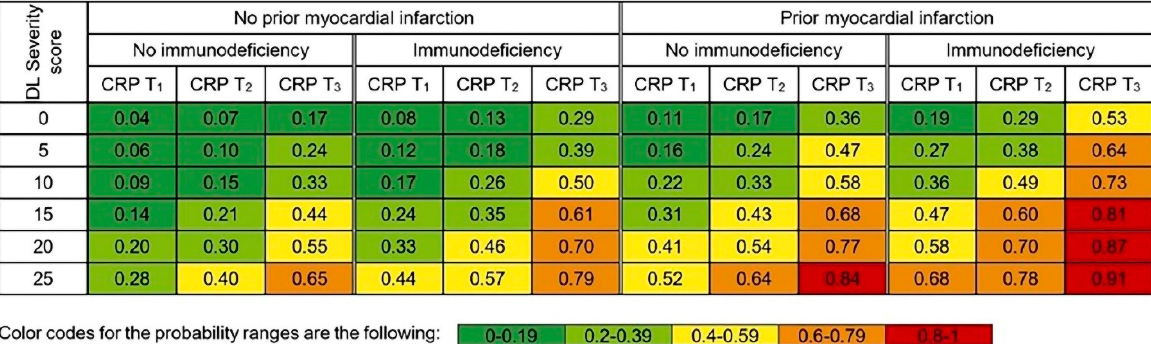
of myocardial infarction, presence of immunodeficiency and CRP tertiles. CRP tertiles: T 1 < 45.1 mg/L; T 2 = 45.1–114.4 mg/L; T 3 > 114.4 mg/L.